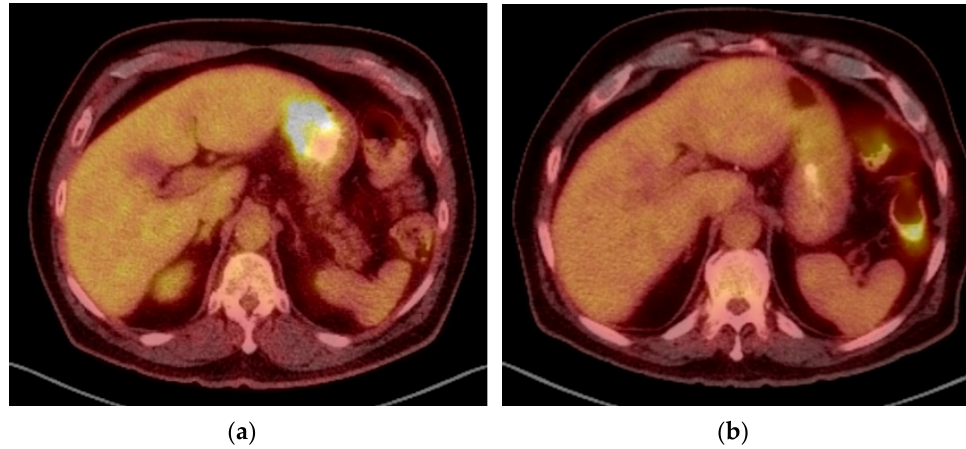
Figure 1. Patient at presentation ( a ) and after 4 cycles of FLOT ( b ) showing response to treatment based on PET